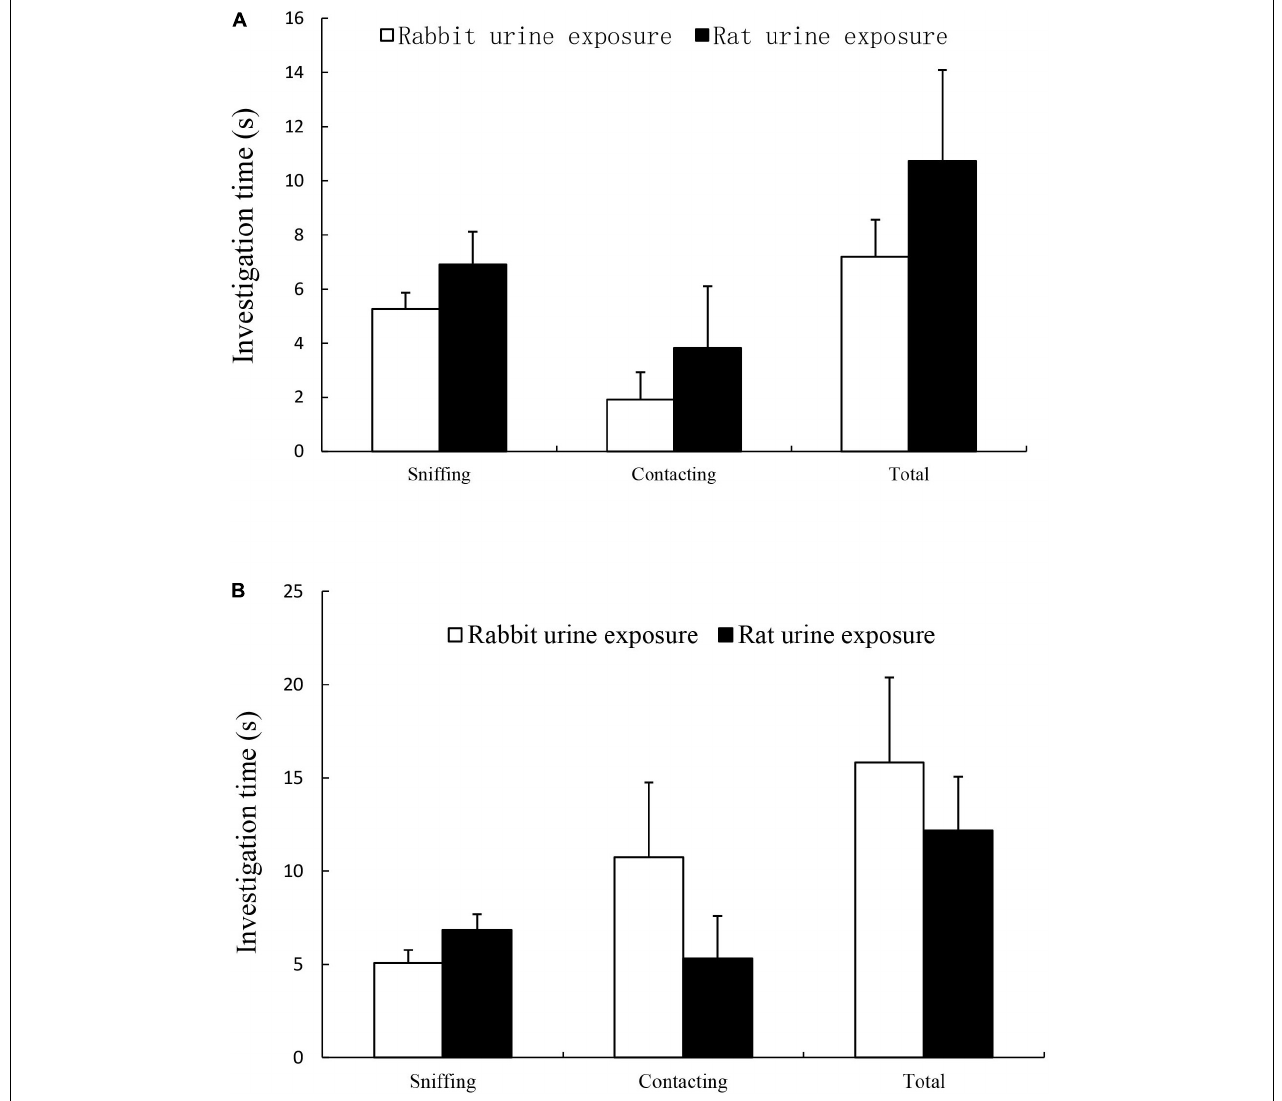
FIGURE 1 | Time spent on sniffing, licking and total (sniffing + licking) in rabbit urine exposure group and rat urine exposure group, including exposure to cattle urine samples (A) and ferret urine samples (B) . Data are expressed as the mean ± SEM.